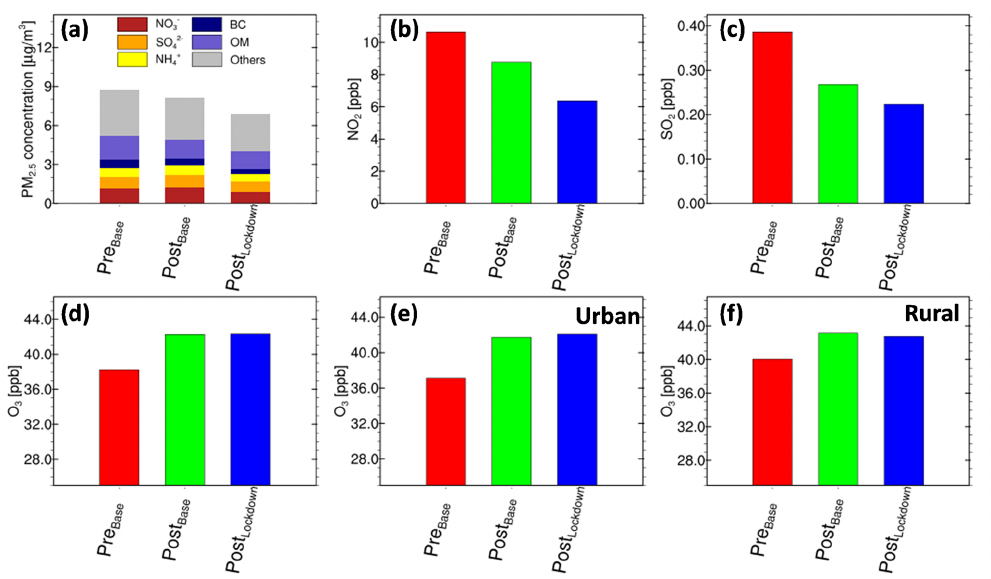
Figure 5. Effects of emission reductions and meteorology conditions on air pollutants. (a–d) Population-weighted concentrations of simu- lated air pollutant concentrations in southern California: (a) PM 2 . 5 components; (b) NO 2 ; (c) SO 2 ; (d) MDA8 O 3 over southern California; (e) MDA8 O 3 over the urban areas of southern California; (f) MDA8 O 3 over the rural areas of southern California. Pre Base , Post Base , and Post Lockdown have the same meanings as in Fig.